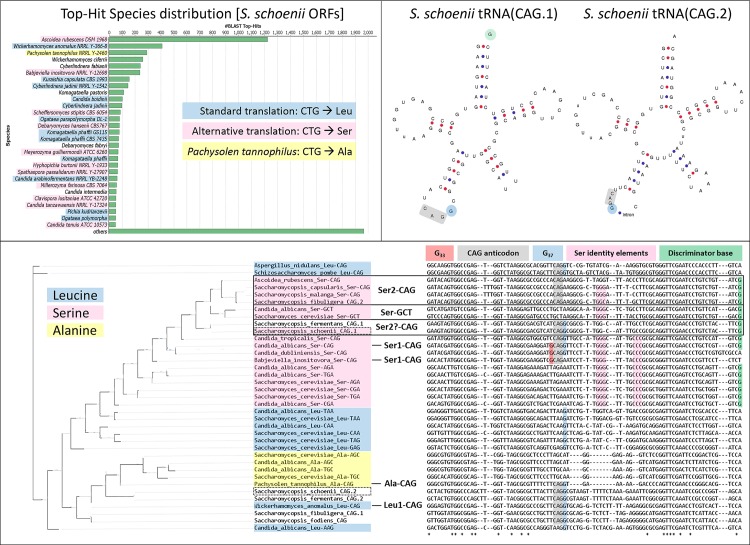
In silico analyses suggest S. schoenii is a CTG clade member.A) A cloudblast of translated S. schoenii ORFs against proteins suggested by nr database. S. schoenii was closely related to several CTG clade members. B) Two CAG-tRNAs were found in the draft S. schoenii genome. C) Alignment of the two S. schoenii CAG-tRNAs with CAG-tRNAs from Saccharomycopsis fermentans [28], C. albicans, C. dubliniensis, C. tropicalis as well as other Leu-tRNAs and Ser-tRNAs from S. cerevisiae and C. albicans. The S. schoenii CAG.2-tRNA aligns the closest with a S. cerevisiae Leu-GAG-tRNA, whereas S. schoenii CAG.1-tRNA aligns closer to the Ser-CAG-tRNAs of other CTG clade yeasts. CAG-tRNA features are color-coded [55–57].